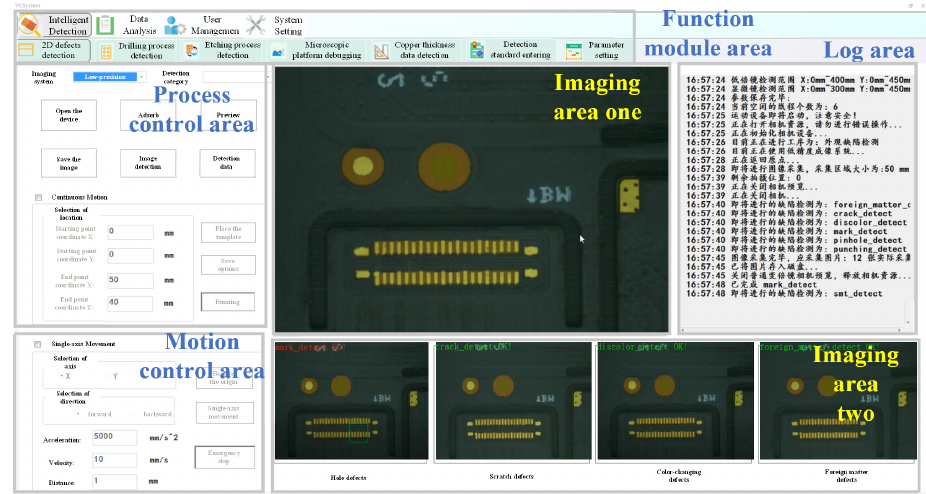
Figure 8. Schematic diagram of the main interface of the system.